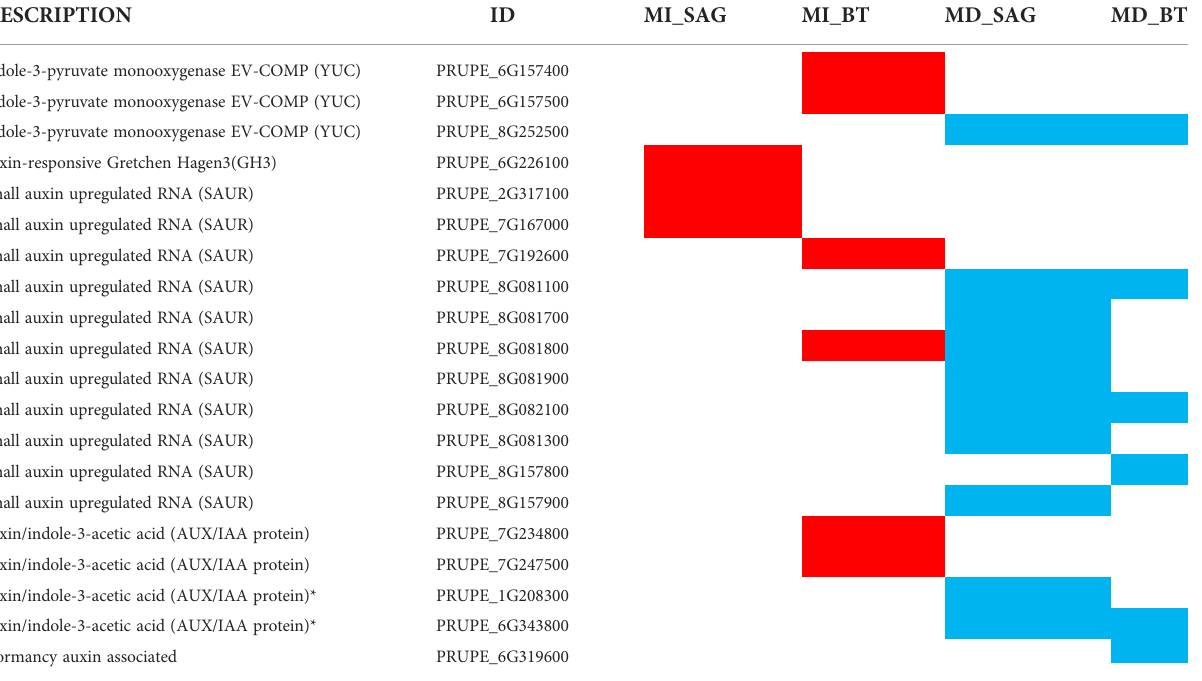
TABLE 2 Expression of monotone genes related to auxin biosynthesis and